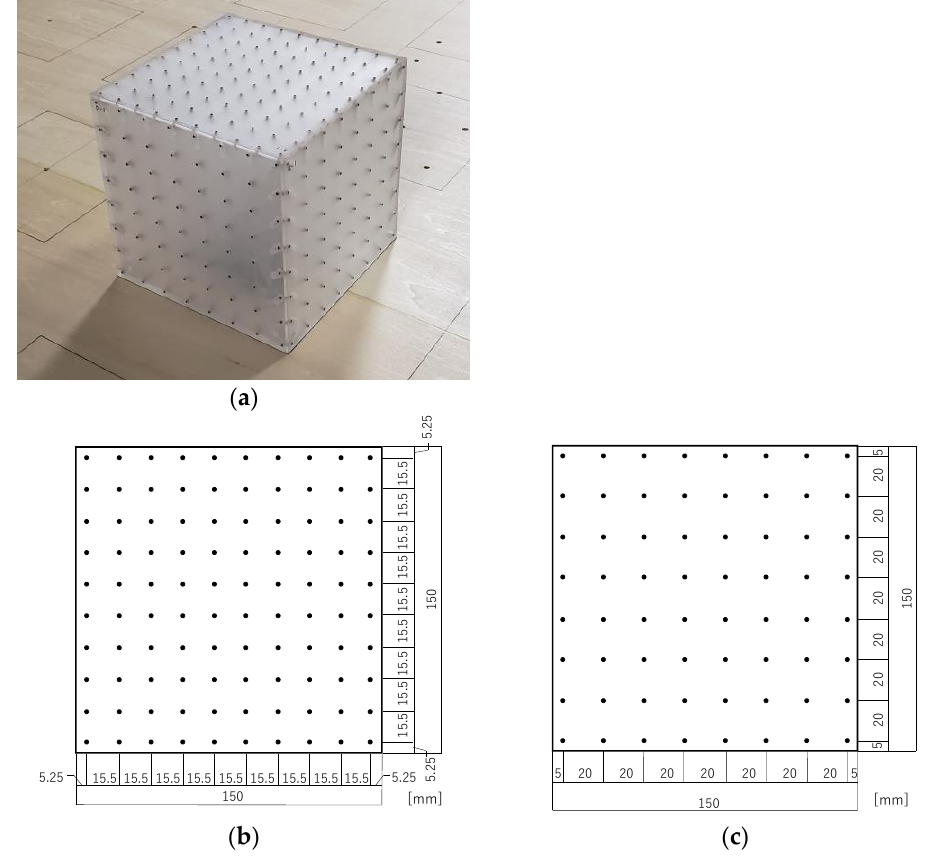
Figure 1. Pressure taps: ( a ) test model for wind pressure measurement; ( b ) pressure taps on roof surface; ( c ) pressure taps on side surfaces.